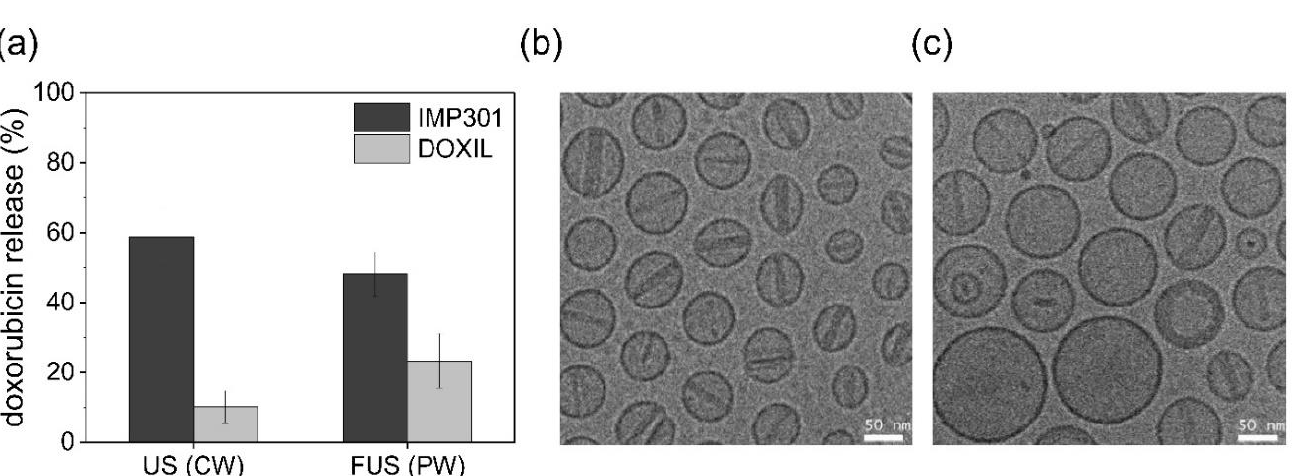
Figure 2. In vitro release behavior of IMP301 and DOXIL. ( a ) Continuous wave ultrasound (CW)- and FUS (pulsed wave, PW)-triggered release of IMP301 (dark gray) and DOXIL (light gray); n = 3. TEM image of IMP301 ( b ) before ultrasound irradiation and ( c ) after ultrasound irradiation.